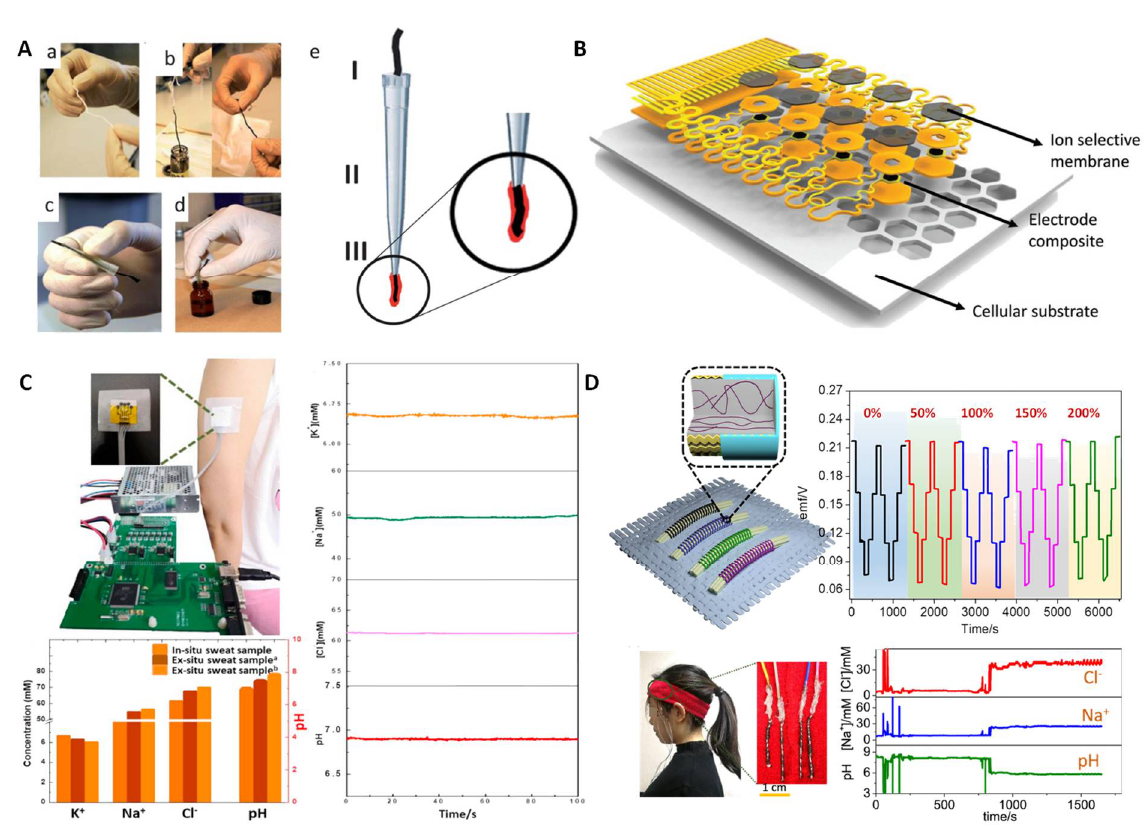
Figure 4. HI–based wearable pH sensors. ( A ) The steps for constructing CNT–cotton–based pH sensing electrodes. Reprinted with permission from [28], Copyright (2013) Royal Society of Chemistry. ( B ) Stretchable ion sensor array with an open cellular structure. Reprinted with permission from [46], Copyright (2017) John Wiley and Sons publications. ( C ) A paper−based multichannel SC−ISE for pH and other ion analysis in sweat. Reprinted with permission from [79], Copyright (2019) Elsevier. ( D ) Fiber−based wearable potentiometric sensor and its carry−over test from 0 to 200%. Reprinted with permission from [80], Copyright (2020) Royal Society of Chemistry.